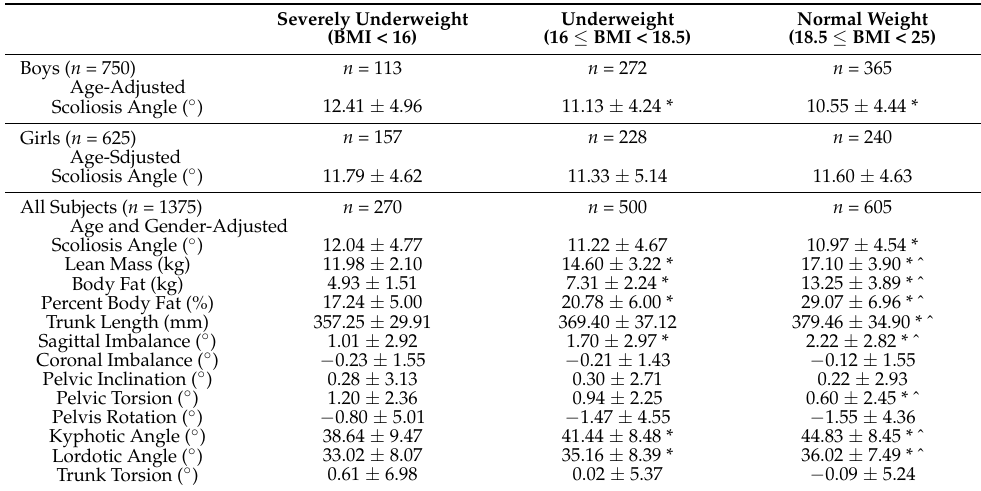
Table 2. Variables according to BMI levels.